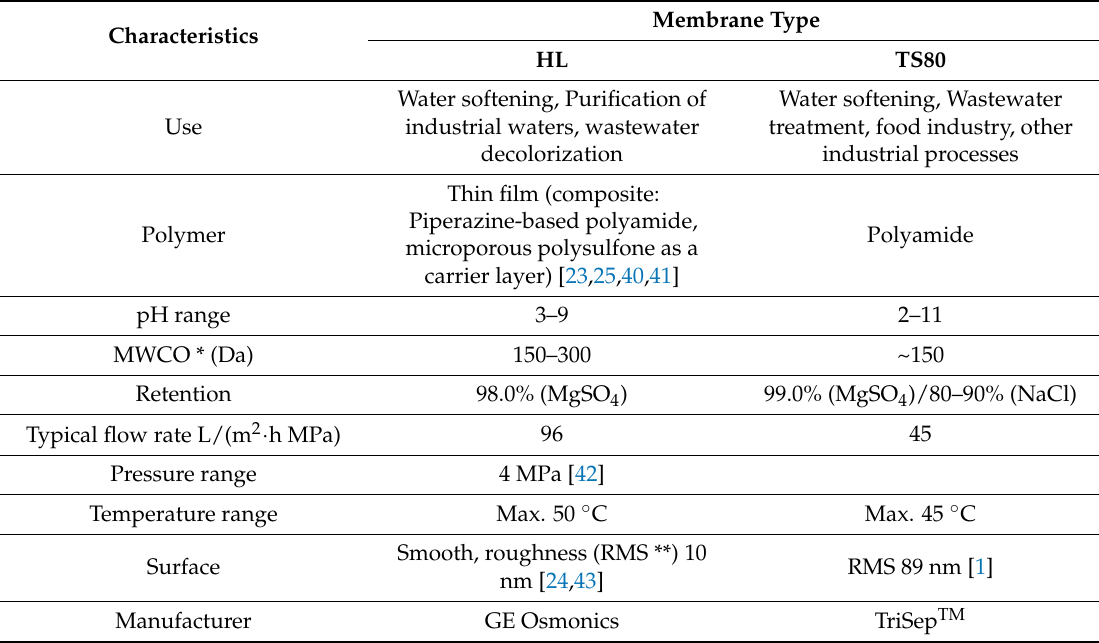
Table 2. Parameters of the tested